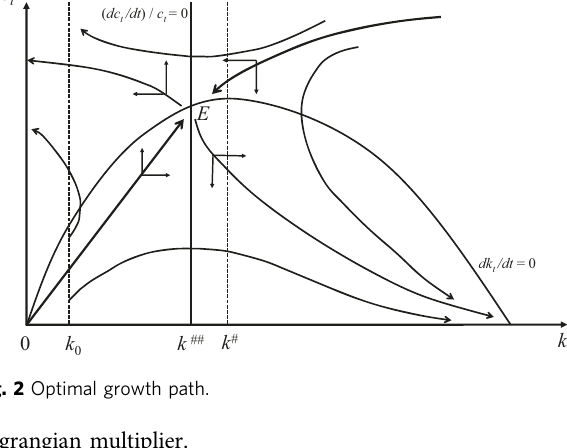
Fig. 2 Optimal growth path.